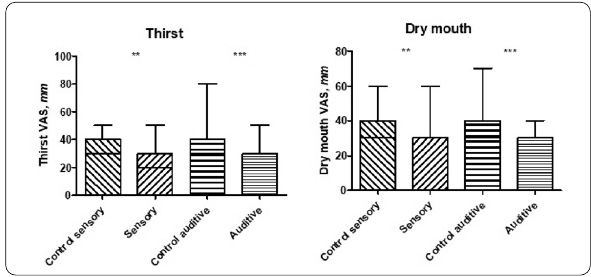
Table I Biomarkers and weaning outcomes in hypovitaminosis D group and normal vitamin D group.